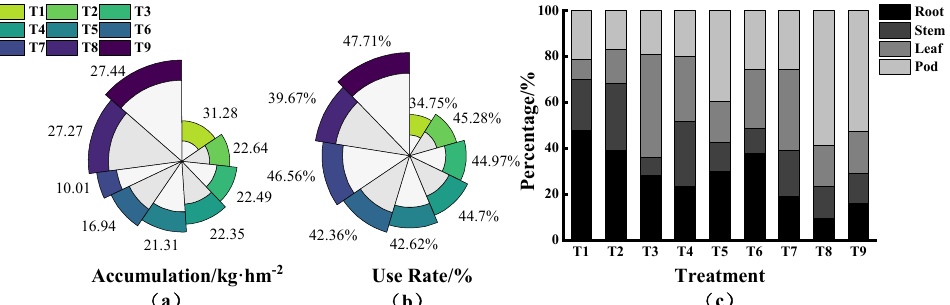
Figure 1. The 15 N fertilizer accumulation, utilization rate, and accumulation percentage in each organ of mung bean relative to the total nitrogen accumulation under different treatments. Note: CK: